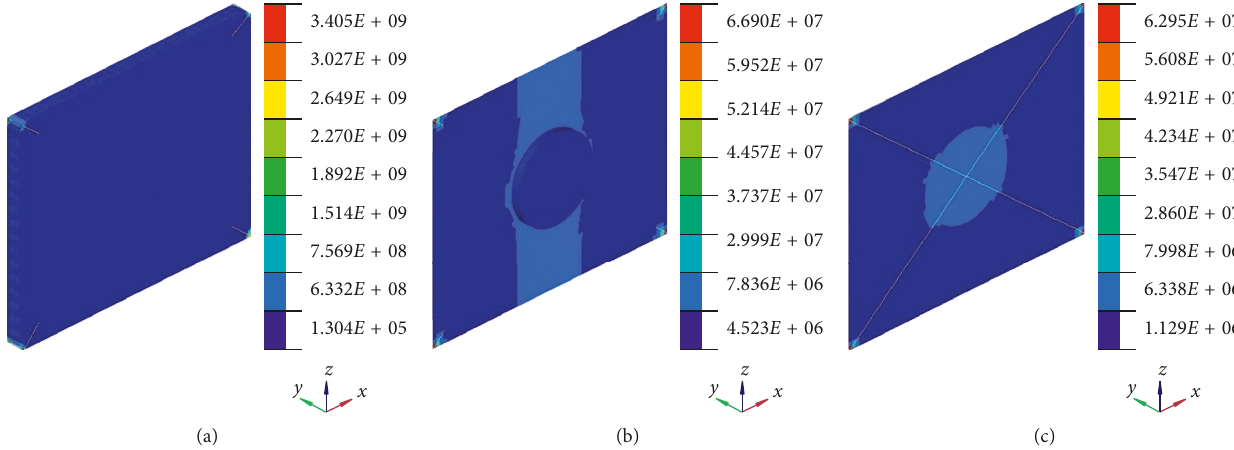
Figure 12: Stress obtained through shock spectrum analysis. (a) Whole entity modeling, (b) equivalent plate, and (c) multilayered